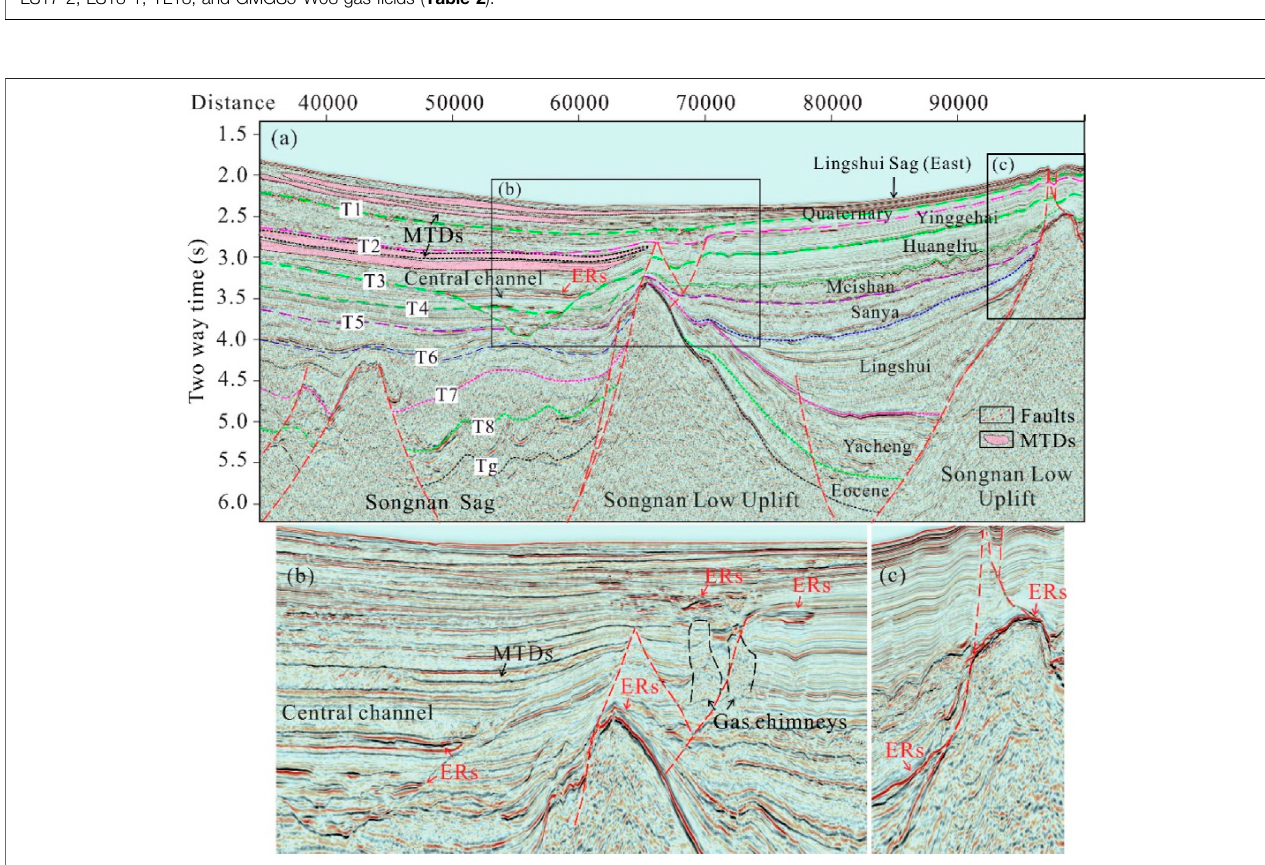
FIGURE5|(A) Representativeseismicpro fi lesoftheSongnanLowUplift. (B,C) PartialenlargeddetailsforthegeologicalcharacteristicsoftheSongnanLowUplift.